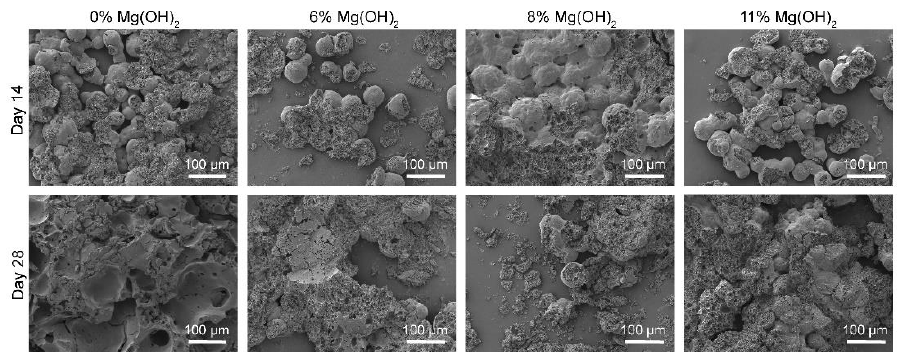
Figure 4. SEM images of microspheres under incubation of different times.